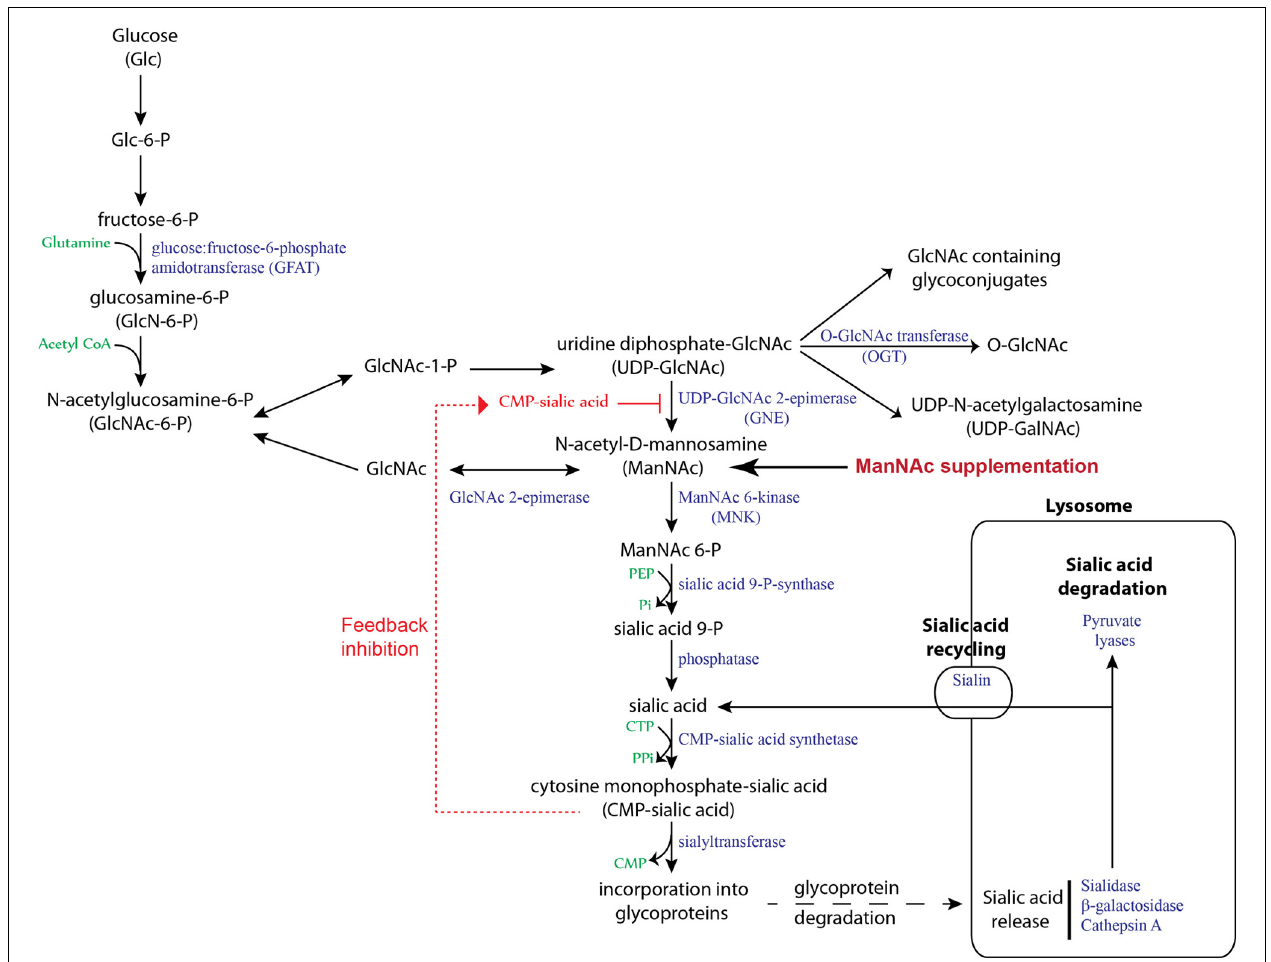
FIGURE 3 | Sialicacidbiosynthesisandrecyclingpathway. Inhumans,sialic acidissynthesizedfromglucose.Theratelimitingstep,catalyzedbyGNE,is subjecttofeedbackinhibition.ManNAcistheproductofthisratelimitingstep,